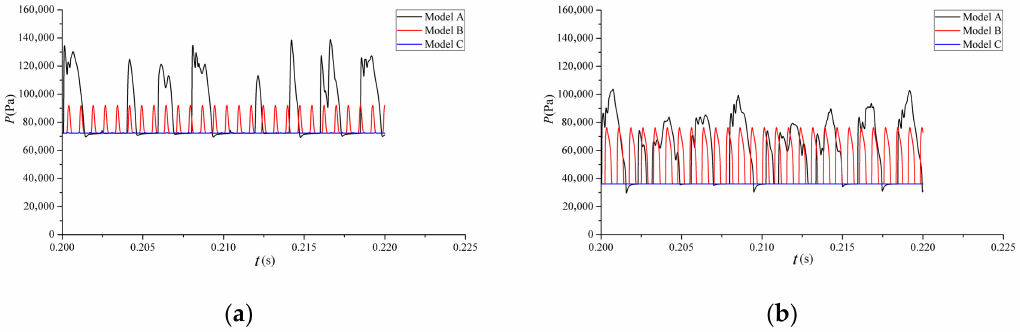
Figure 12. Pressure change at sampling point 4. ( a ) Upper wall ( b ) Lower wall.